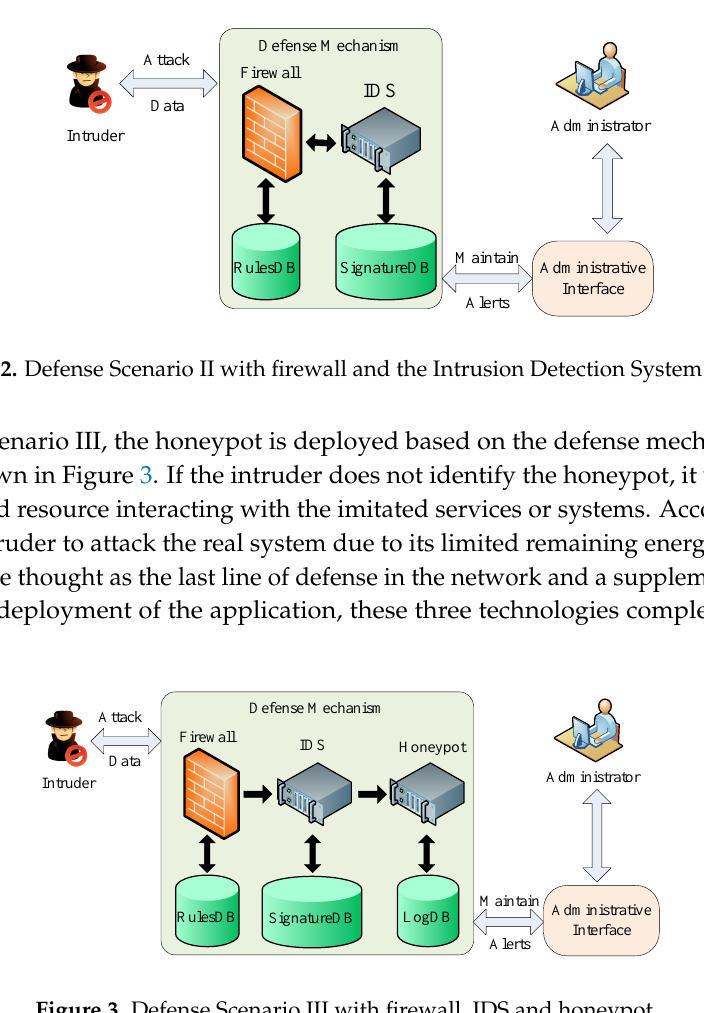
Figure 3. Defense Scenario III with firewall, IDS and